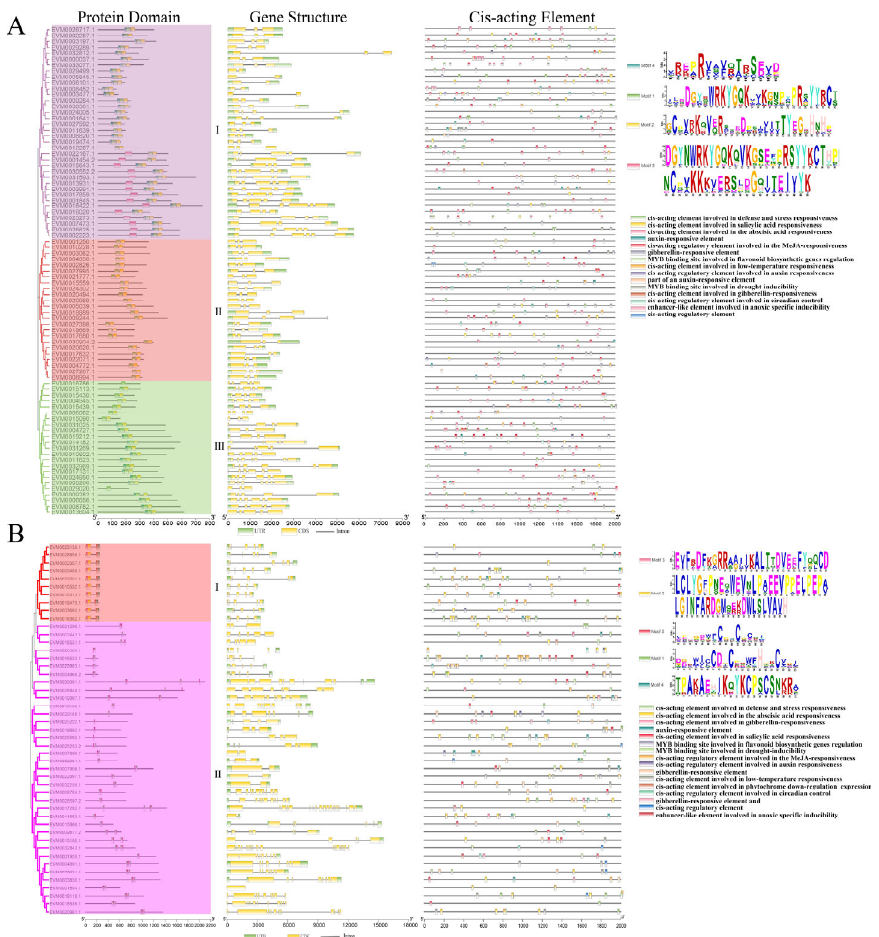
Figure 2. Analysis of protein domains, gene structures, and cis ‐ acting elements. WRKY and PHD gene families motif and protein conservative domain ( A , B ). Cis ‐ acting elements are located within 0 to 2000 bp upstream of the gene initiation codon.